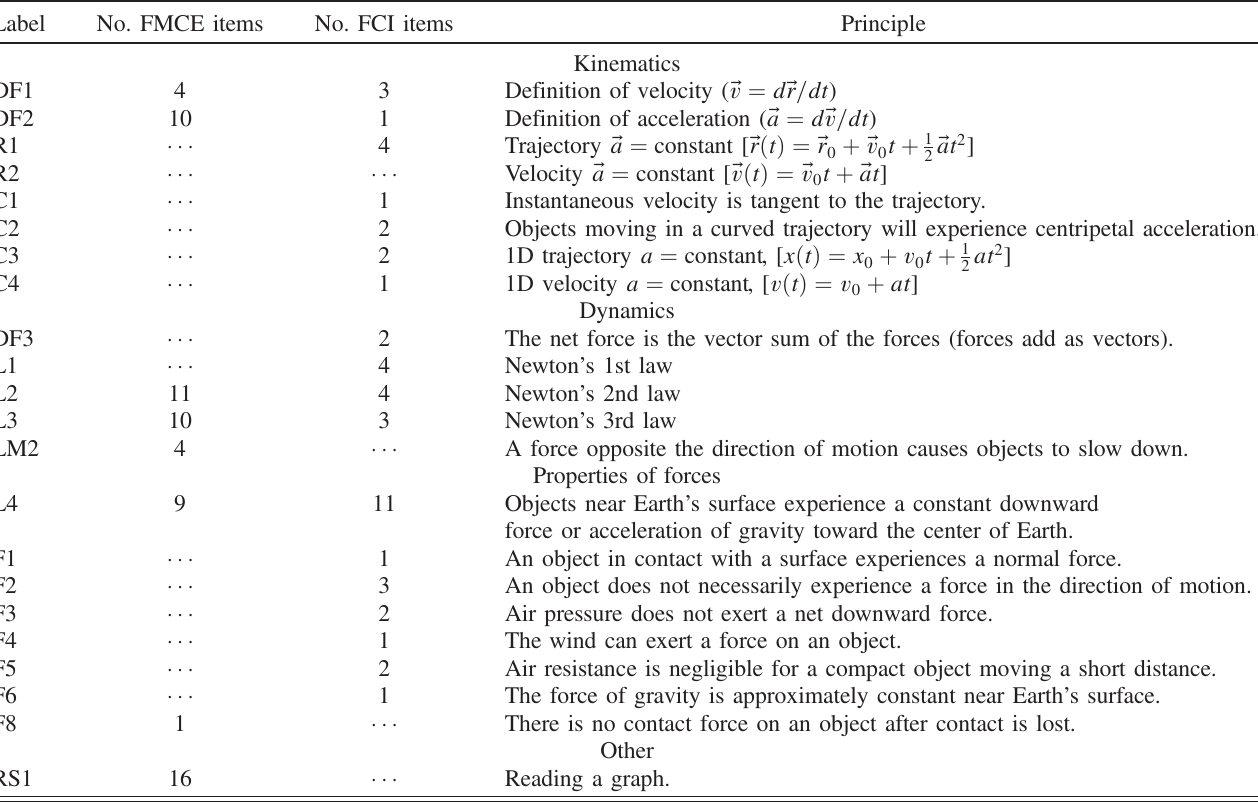
TABLE VII. Comparison of the optimal model of Newtonian mechanics as tested by the FCI and the FMCE. The number of items in each instrument using the principle is also presented. Label No. FMCE items